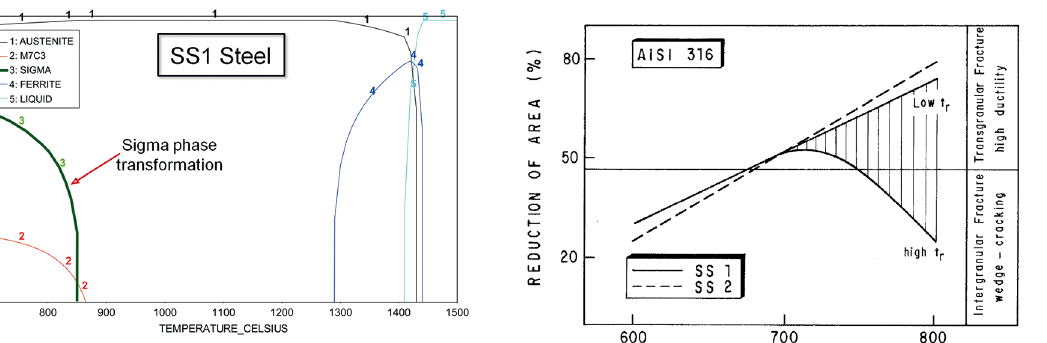
Figure 5. Step cooling Thermo-Calc-based diagram for SS1 steel. The sigma phase transformation curve is indicated by the arrow.